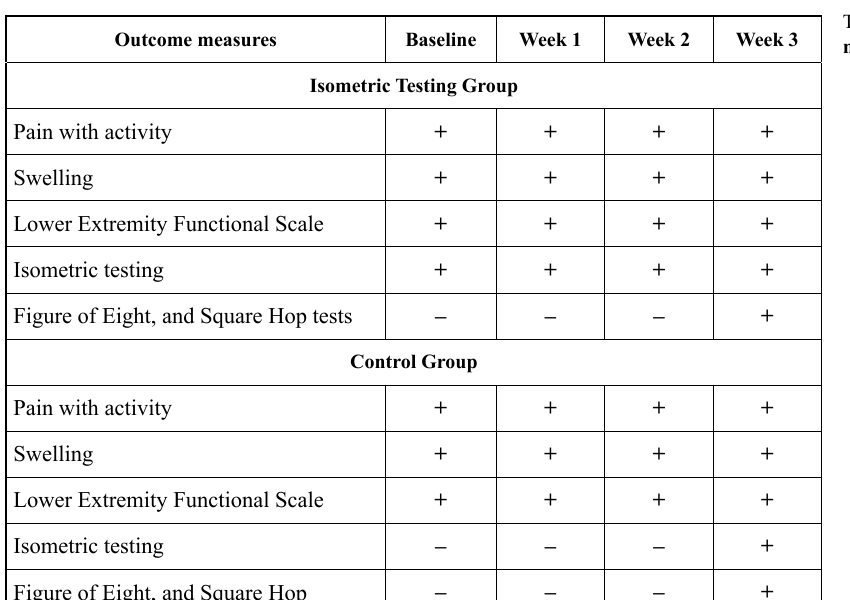
Figure of Eight, and Square Hop